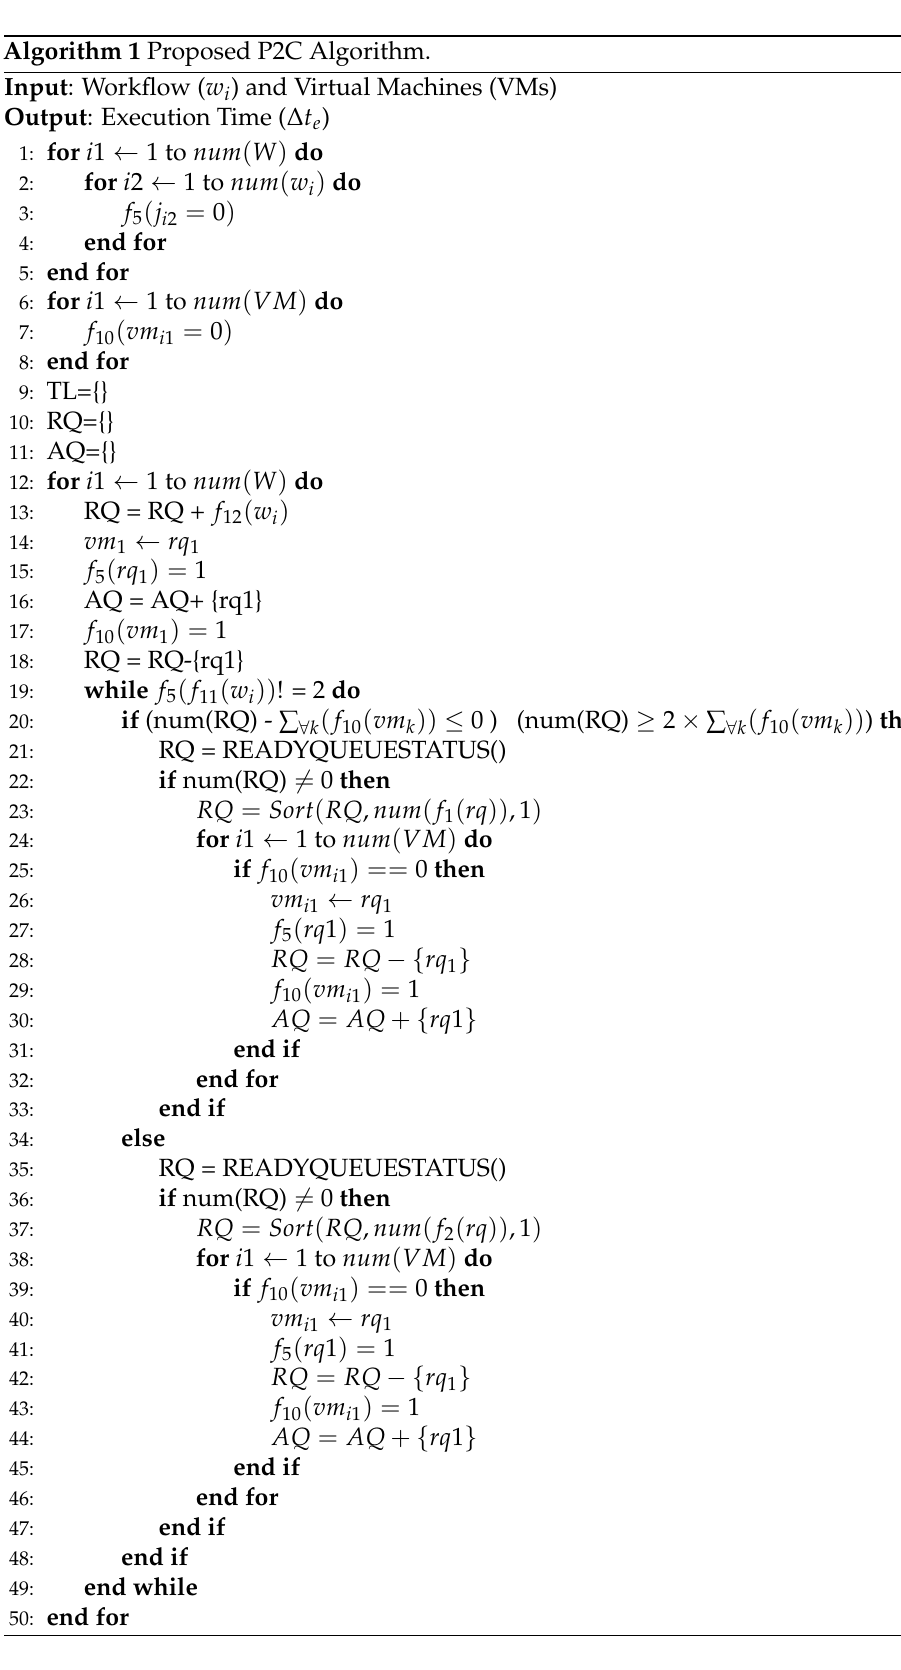
Algorithm 1 Proposed P2C